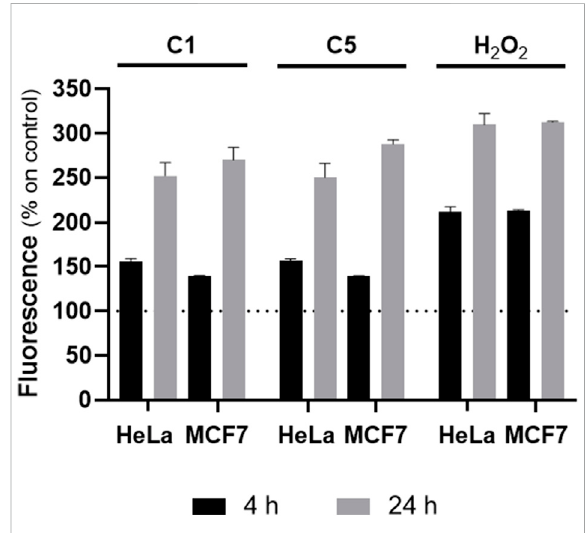
FIGURE 5 In vitro reactive oxygen species (ROS) production. Intracellular levels of ROS, measured with the DCFDA assay in HeLa and MCF7 cancer cells for complex C1 and C5 at their IC 50,